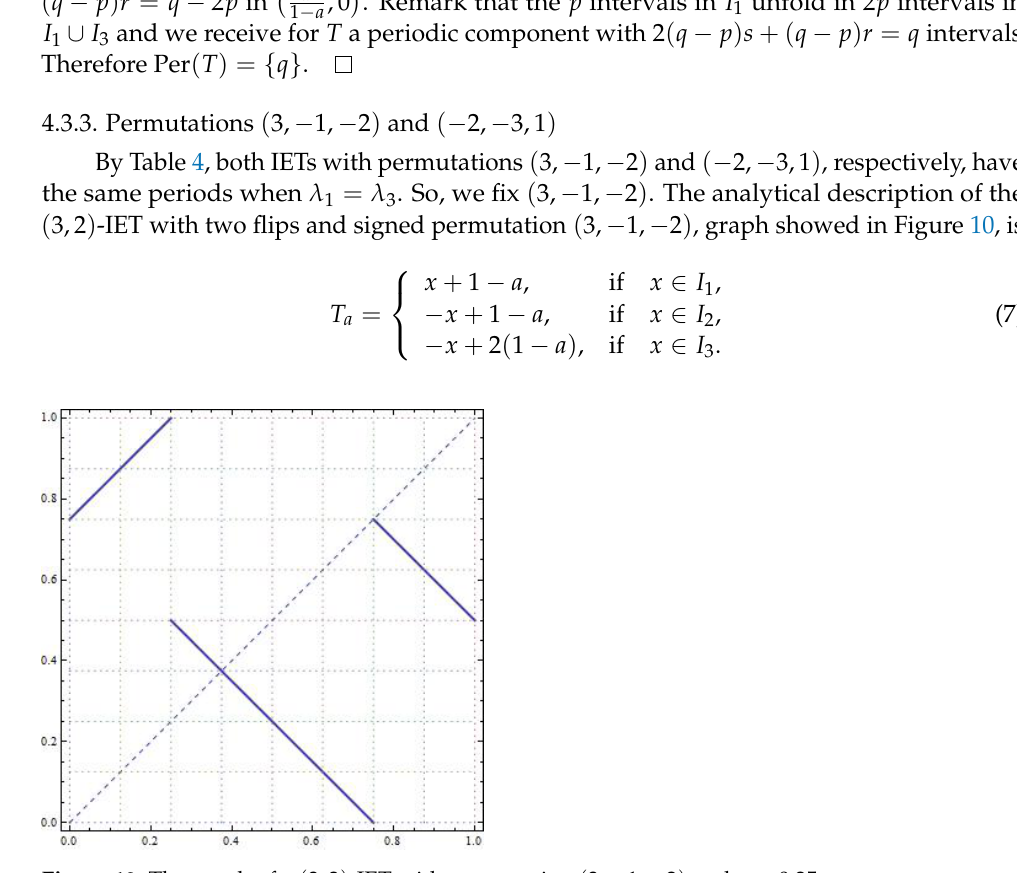
Figure 10. The graph of a ( 3,2 ) -IET with permutation ( 3, − 1, − 2 ) and a =